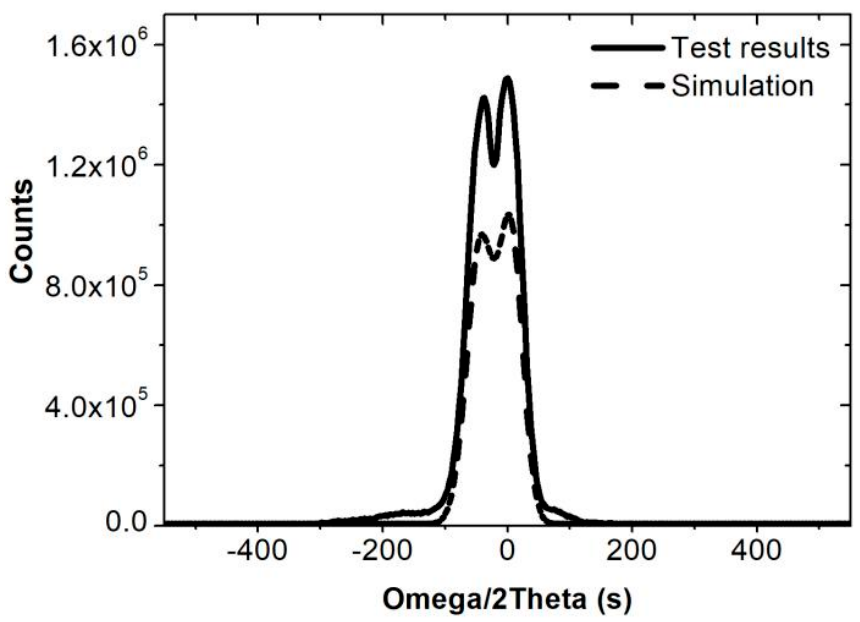
Figure 2. Omega-2Theta curves of the GaInP BSF layer and simulated curves .